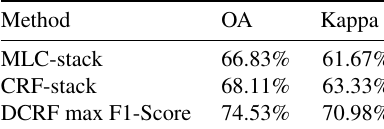
Table 2. Comparison of DCRF max F1-score to stacking multitemporal images together as input bands for classification.